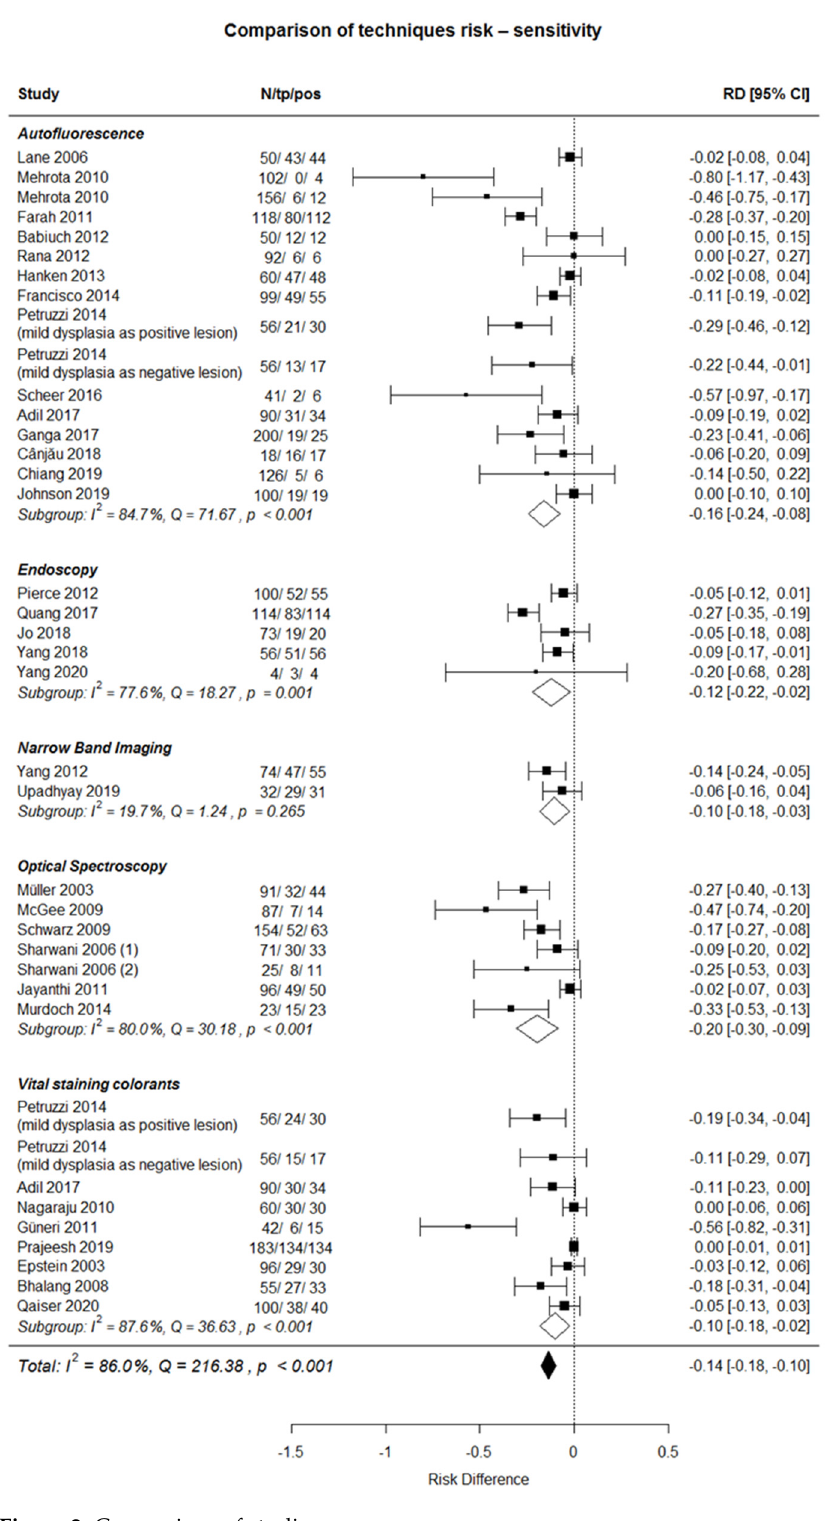
Figure 2. Comparison of